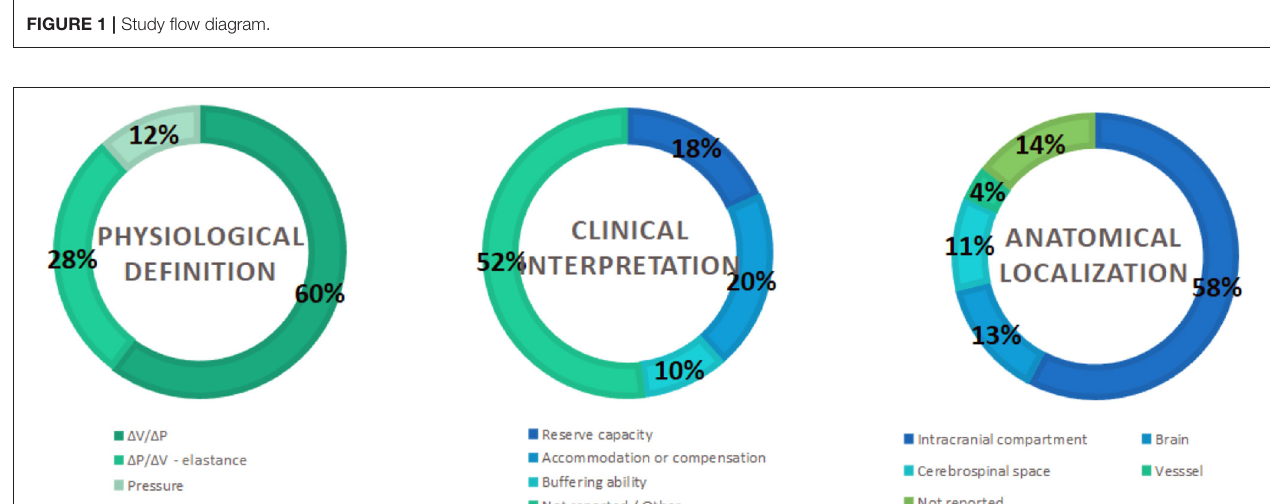
FIGURE 2 | Percentage of mapped